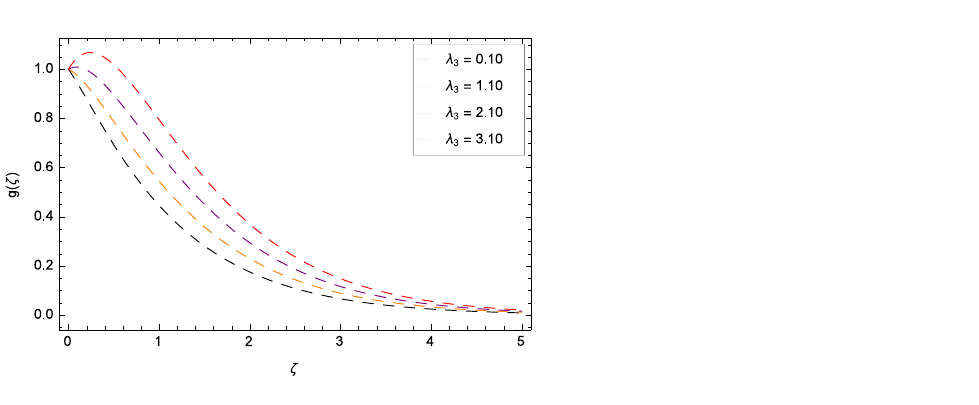
Figure 10. Pattern of graph curves on account of (cid:31) 3